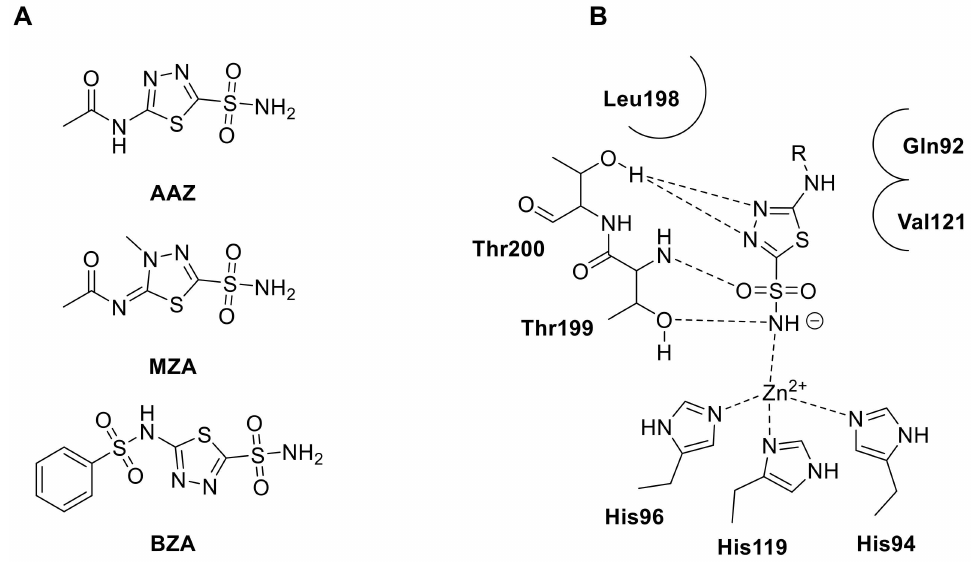
Figure 6. ( A ). Structures of clinically thiadiazole sulfonamide acetazolamide ( AAZ ), methazolamide ( MTZ ) and benzolamide ( BZA ). ( B ). Schematic representation of the binding mode of thiadiazole sulfonamide derivatives within hCA II active